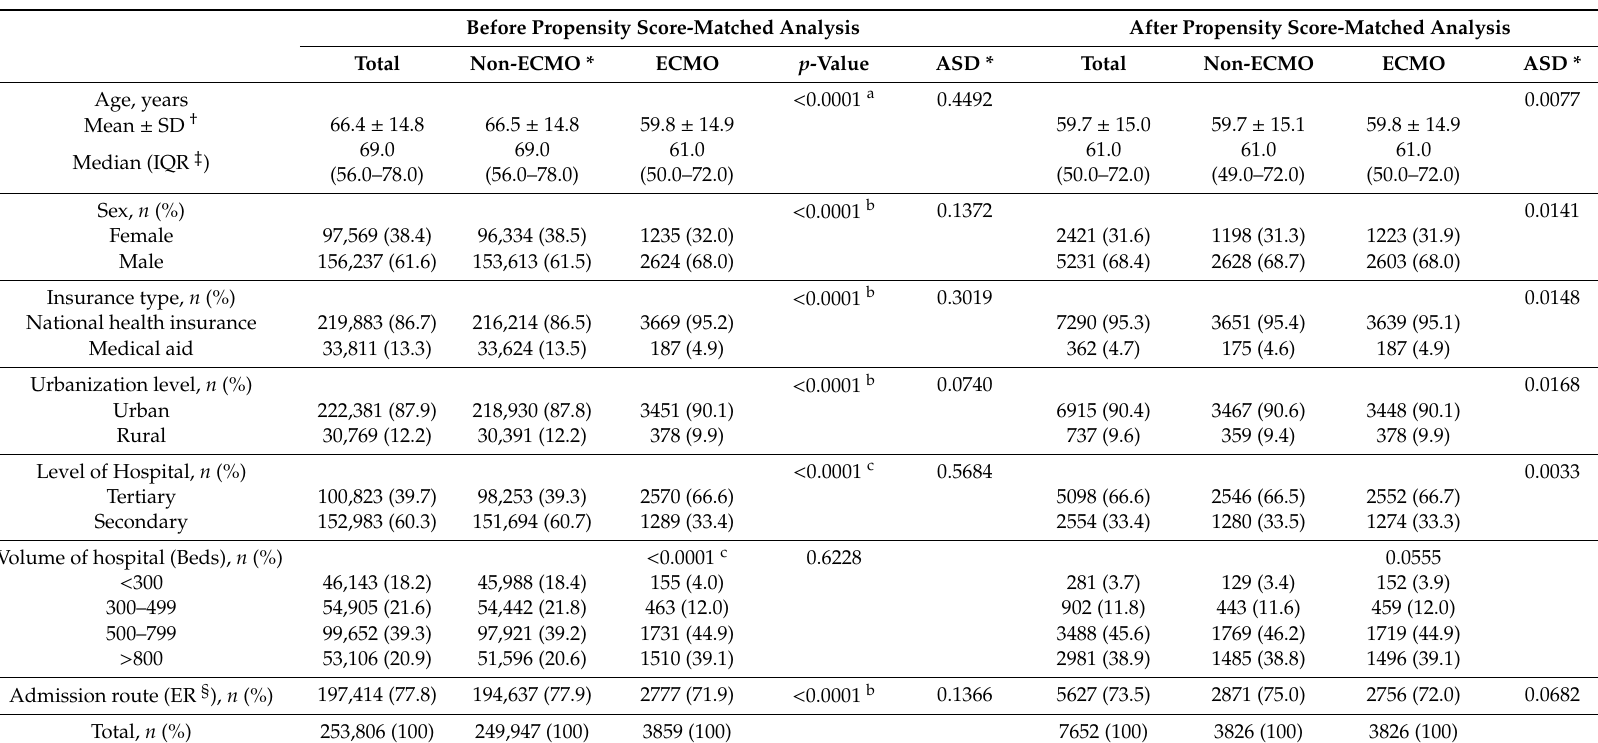
Table 1. Characteristics and hospitalization-related factors of cardiac arrest patients according to application of extracorporeal membrane oxygenation. Before Propensity Score-Matched Analysis After Propensity Score-Matched